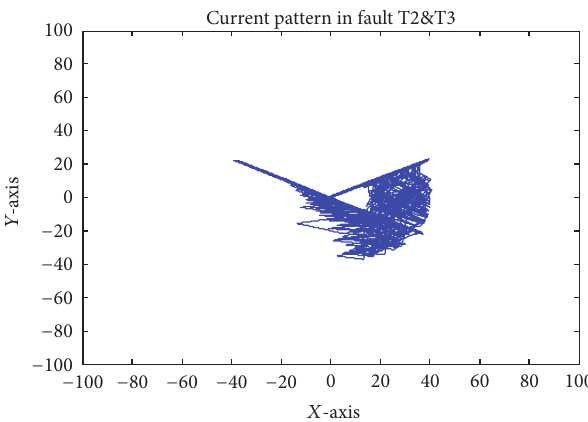
Figure 12: 𝛼 - 𝛽 transformed current pattern graph for system in multiple fault mode T2&T3.